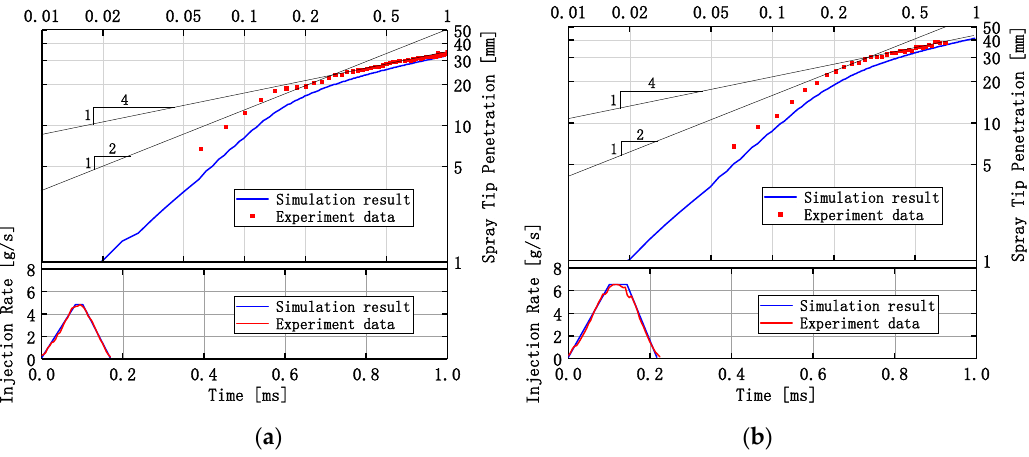
Figure 3. Comparison of spray tip penetrations between the simulation result and experiment data under ( a ) the injection quantity of 0.417 mg and ( b ) injection quantity of 0.833 mg.